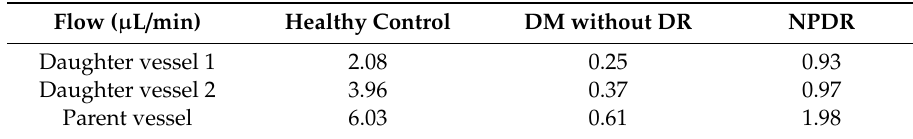
Table 9. Summary of blood flow at a vessel bifurcation in healthy controls, diabetes without diabetic retinopathy, and non-proliferative diabetic